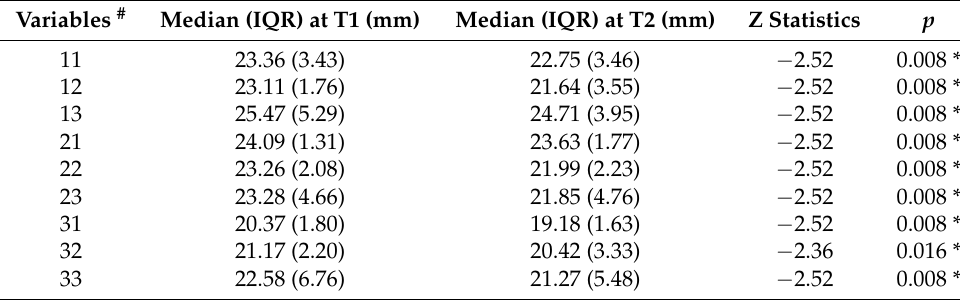
Table 1. Tooth length (root length and crown length) changes in SLL group. Variables